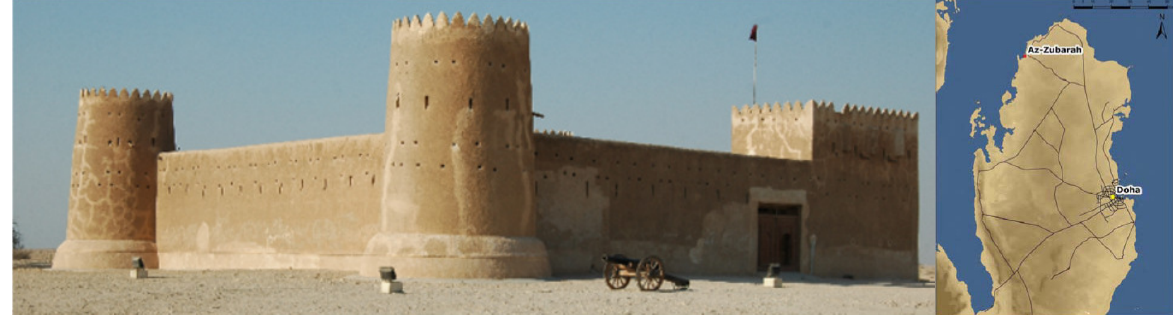
Figure 1: Southern and western facade of the Al Zubarah fortress in Qatar (left), map of Qatar (right)